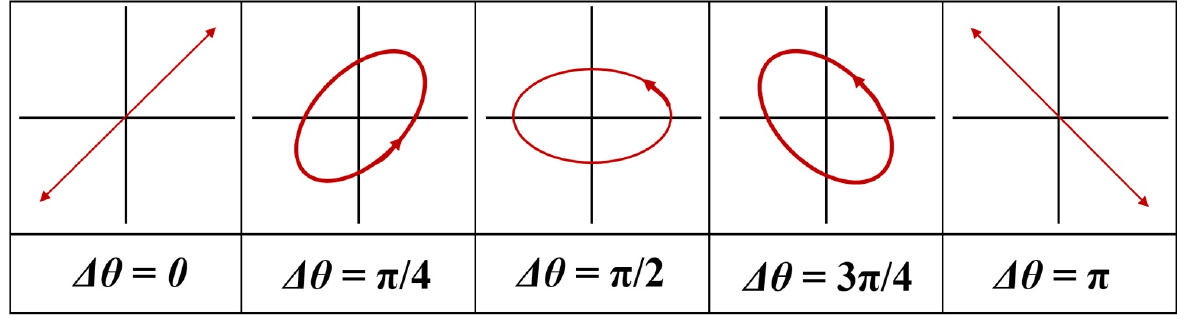
Figure 6. Characteristics of polarization according to the rotation angle of the filter ( E 2 ). For example, when the light reflection intensity ( I ref ) passes through two filters ( θ Ep = 90 ◦ difference) ( E 1 = 0 ◦ , E 2 = 90 ◦ ), the light reflection intensity ( I ref ) at the p 3 position is reduced by more than half. Eventually, the intensity of light reflection ( I ref ) is lowered by more than half compared to the intensity of light ( I Ep ). The reason for this is that, as in Malus’s law in Equation (8), when the rotation angle of the first filter ( θ ref = 0 ◦ ) is fixed, when the second filter is rotated at 90 ◦ ( cos θ Ep = 90 ◦ ), the intensity of light reflection ( I ref ) becomes 0 [19–21].